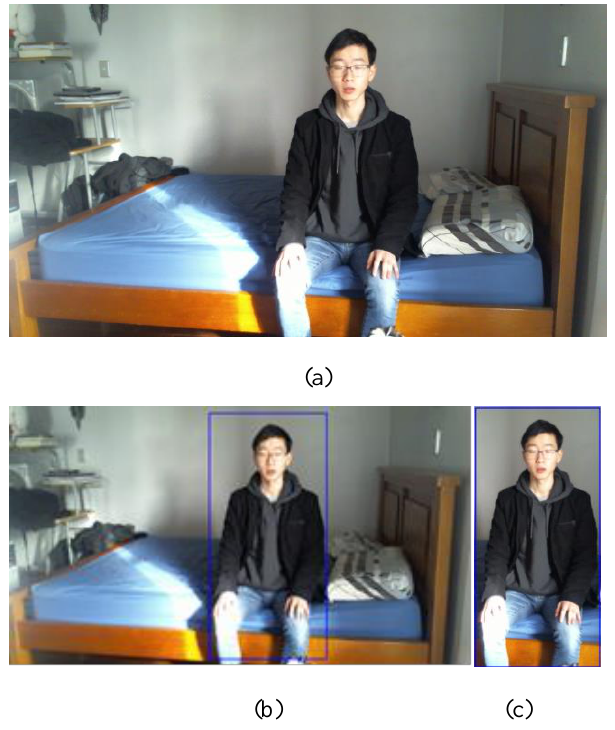
Fig. 2. Posture recognition process, (a) Input image from the webcam, (b) Identification of human detection by blue bounding box, and (c) Cropped image with removal